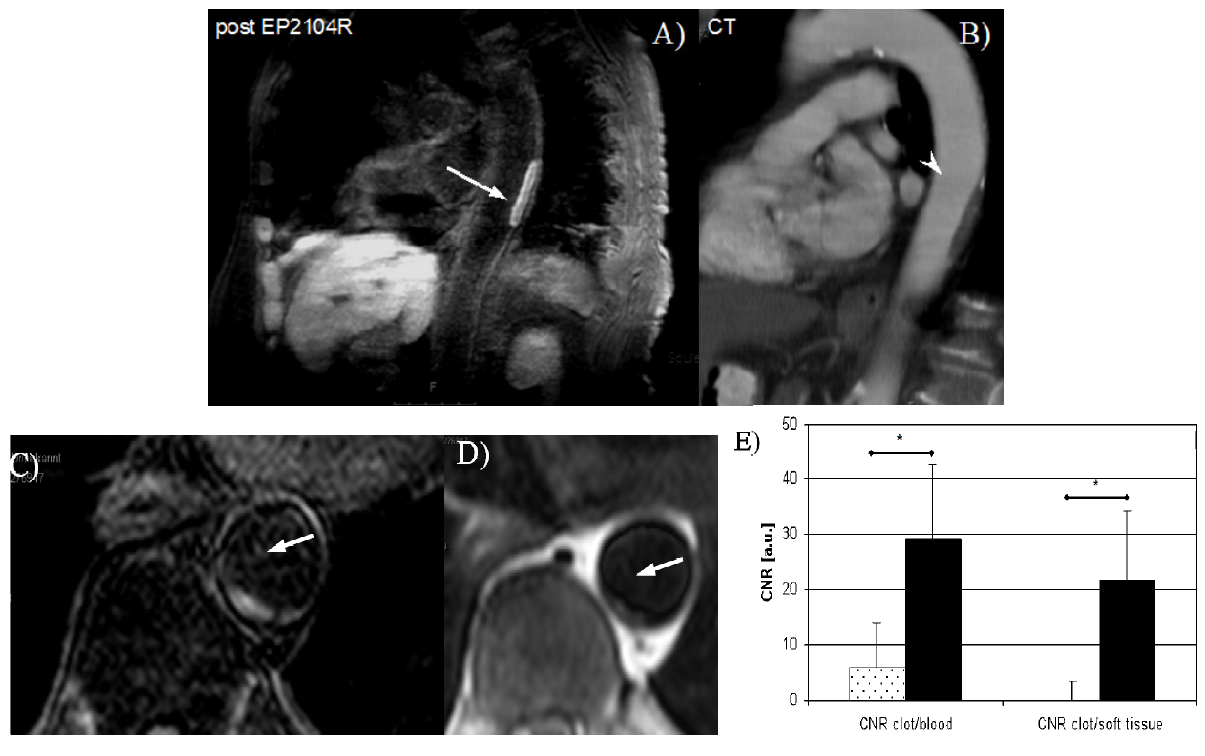
Figure 11. Human thrombus imaging using EP-2104R, a fibrin binding contrast agent, in a patient with aortic thrombus. A mural aortic thrombus is well delineated on inplane post EP-2104R black blood MR images ( A ) while differentiation between thrombus and vessel wall is poor on multi slice CT images ( B ). Excellent aortic thrombus visualization on cross-sectional delayed enhancement images post EP-2104R ( C ) while differentiation between thrombus and vessel wall is poor on pre contrast black blood turbo spin echo ( D ) or gradient echo ( E ) MR images